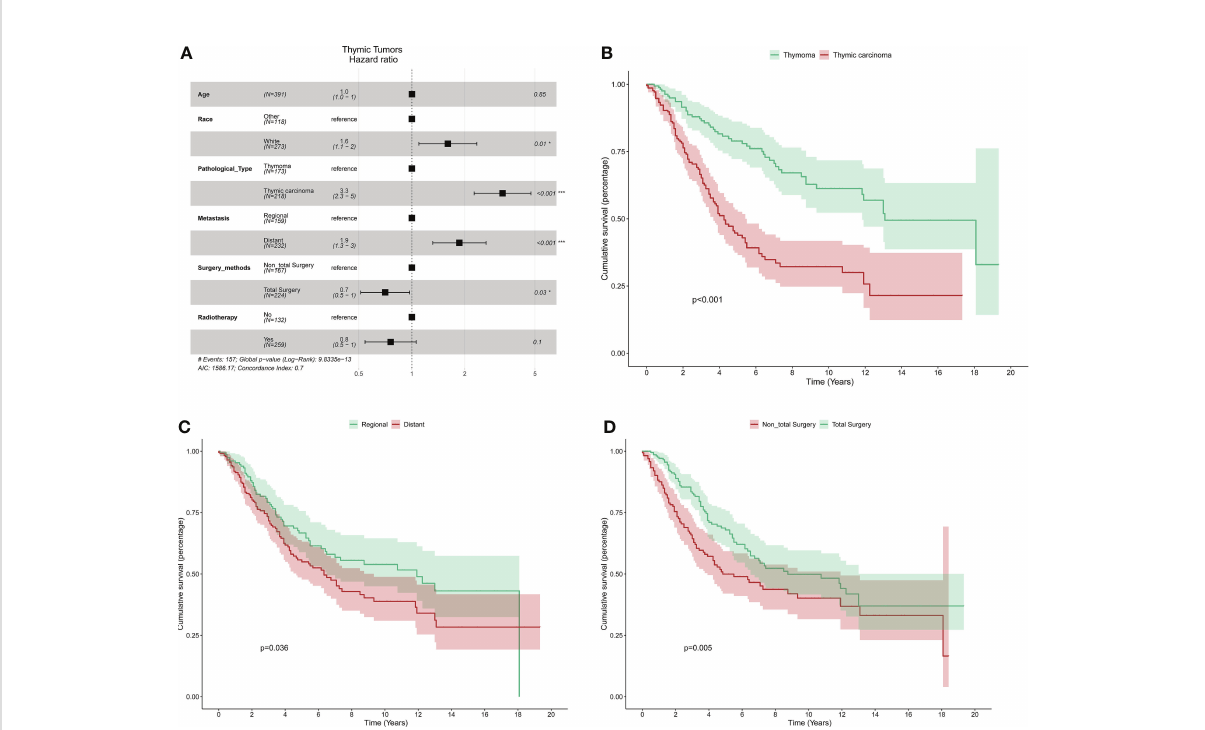
FIGURE 3 The multivariate cox analysis: (A) Forest plot showing prognostic factors for all the patients with surgery. The K – M curve for pathological type (B) , metastasis (C) , and surgical methods (D)